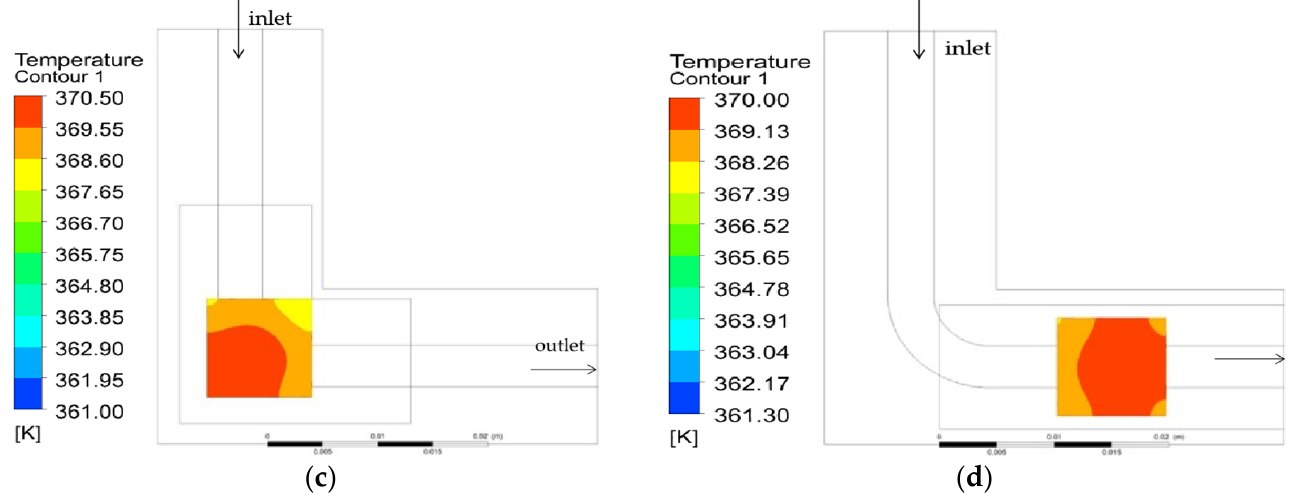
Figure 11. Temperature distribution when the heat source is set: ( a ) in front of the bend; ( b ) near the bend; ( c ) just above the bend; ( d ) behind the bend.